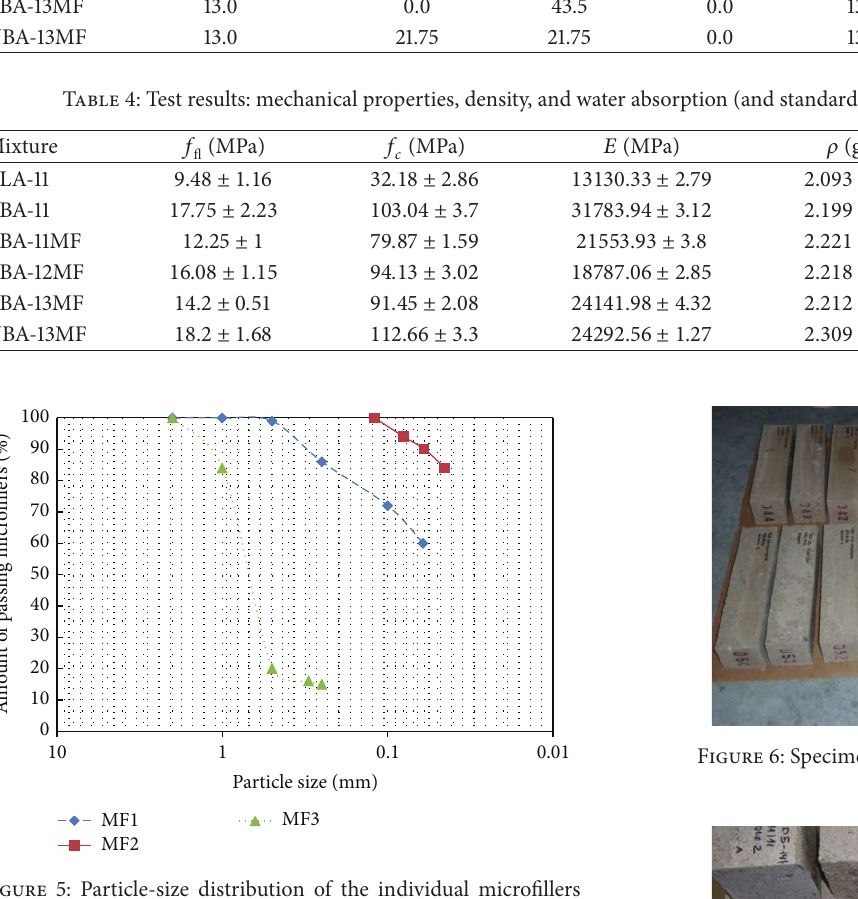
Figure 5: Particle-size distribution of the individual microfillers used in the study (MF1, MF2, and MF3).